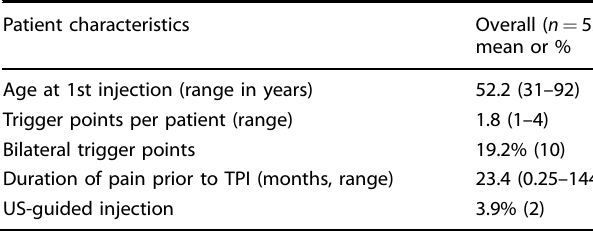
Table 1. Descriptive patient characteristics.